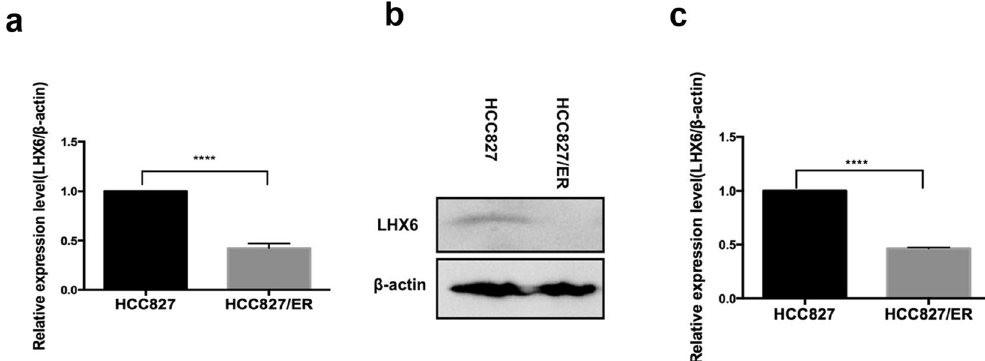
Figure 3. LHX6 expression is down-regulated in HCC827/ER cells at both translational and transcriptional levels. ( a ) qRT-PCR assay reveals down-regulation of LHX6 mRNA expression in HCC827/ER cells than in HCC827 cells ( P < 0.0001); ( b and c ) Western blotting analysis shows down-regulation of LHX6 protein expression in HCC827/ER cells than in HCC827 cells ( P < 0.0001). All data are expressed as mean ± SD from three independent experiments. **** P <